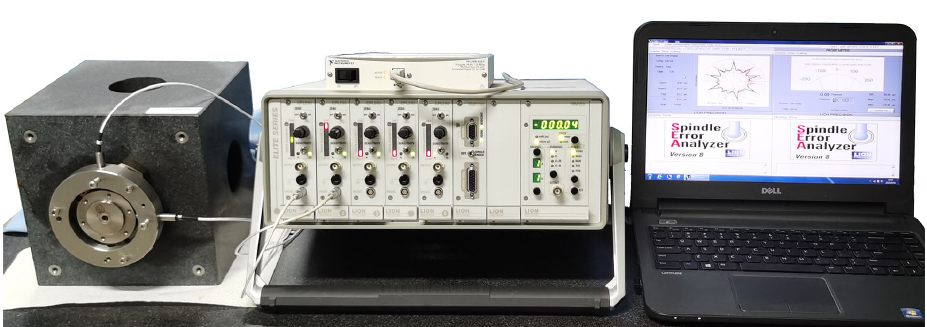
Figure 9. Test rig of spindle rotation error measurement.